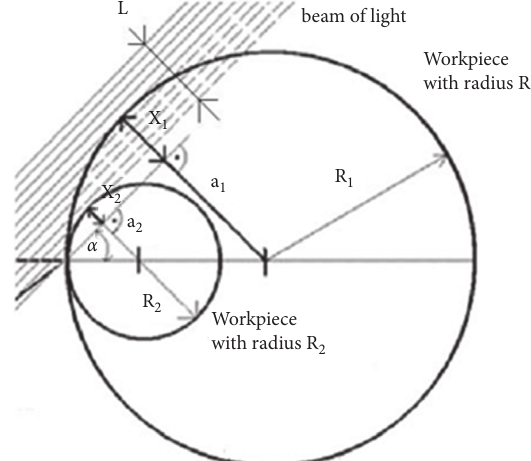
Figure 2: The relationship of parameters in the position of light beam and workpiece.